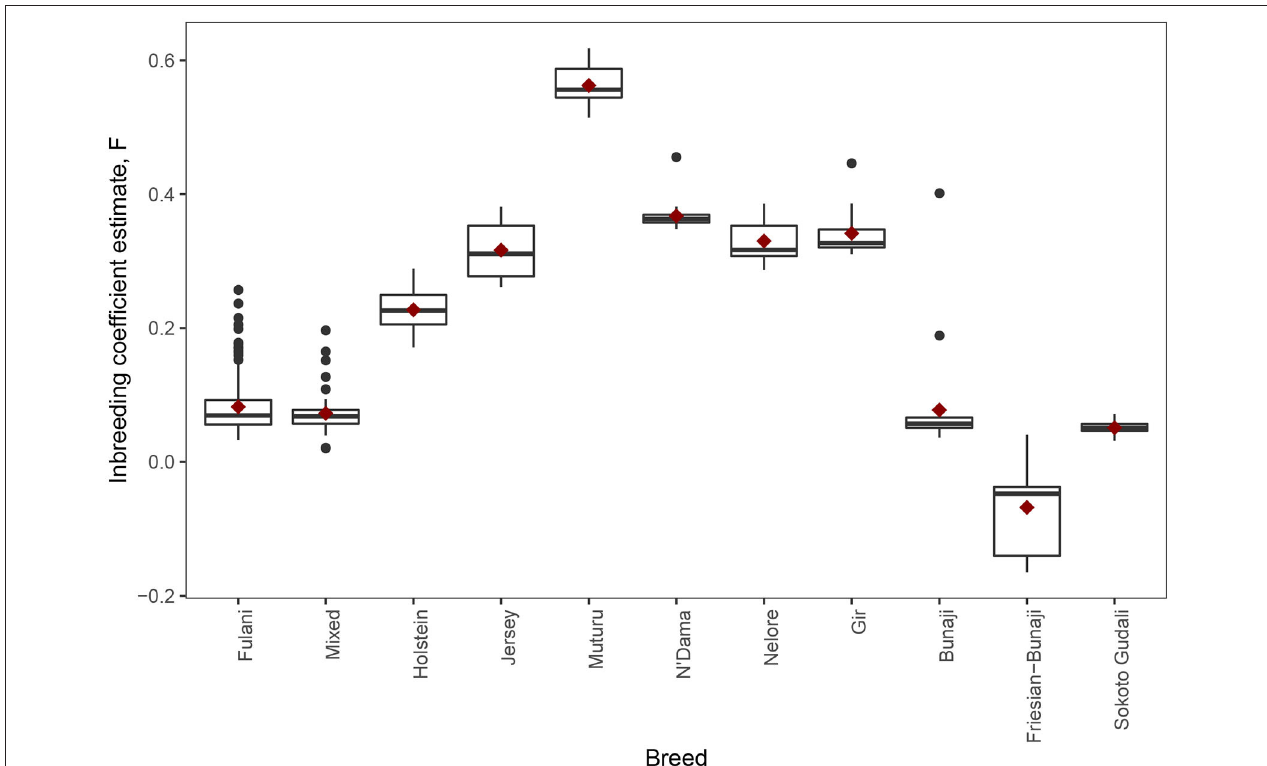
FIGURE 5 | The observed inbreeding coefficient estimate, F, for each animal by breed. The red diamond represents the mean value for each breed.